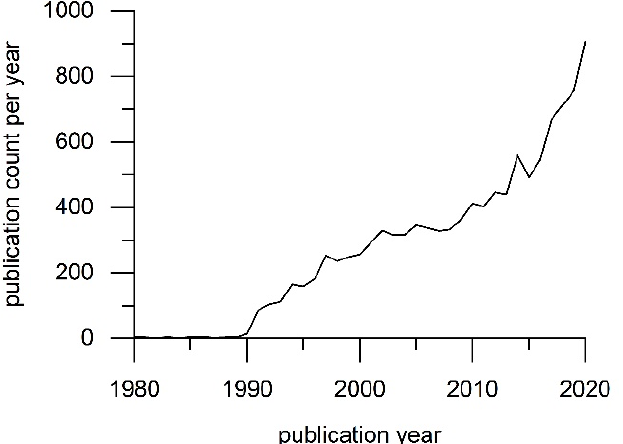
Figure 1. Publications referring to enzyme cascades or multi-step enzyme reactions in their title,